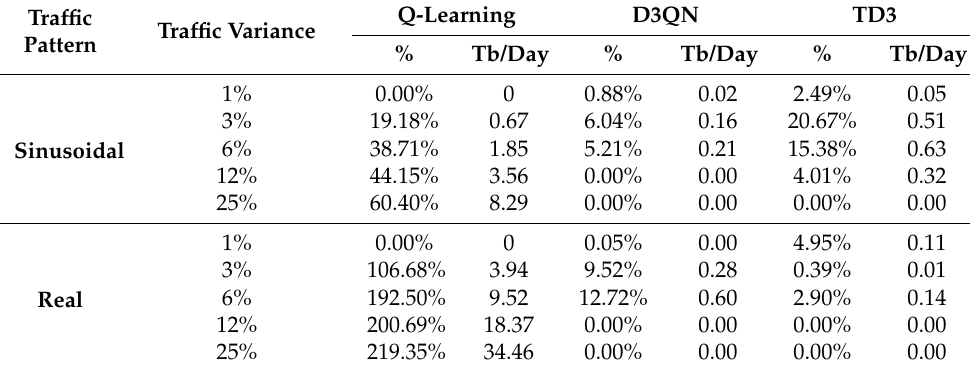
Table 3. Additional overprovisioning when fixing ρ conservatively.